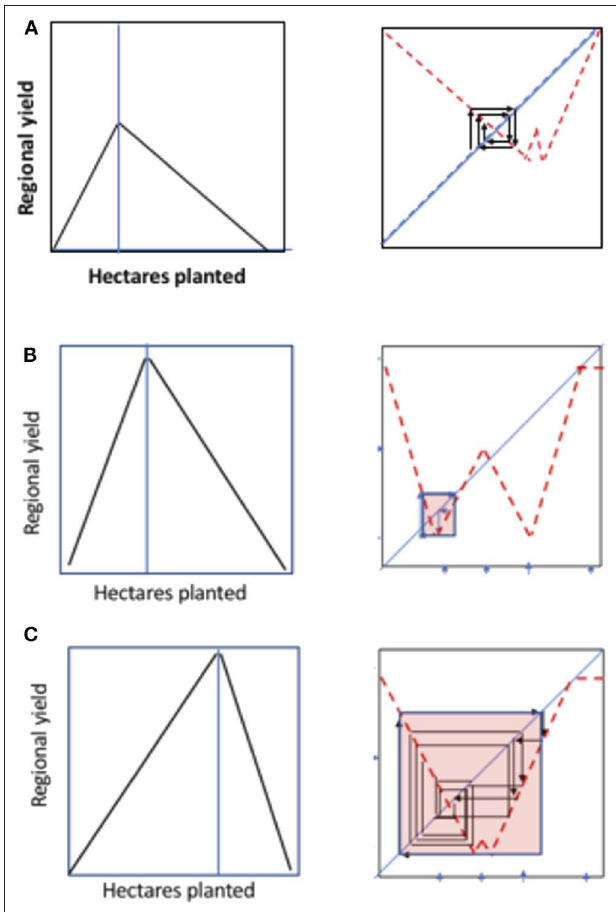
FIGURE 14 | Illustration of changed dynamics resulting from an increase in the critical planting density that gives rise to ecological blowback. (A) Reduced expected yield at critical planting density (i.e., density at which ecological decline begins) and reduced planting density, yielding a stable equilibrium point. (B) High expected yield and reduced critical planting density yielding a “constrained” chaotic attractor. (C) High expected yield and increased critical planting density yielding an “expansive” chaotic